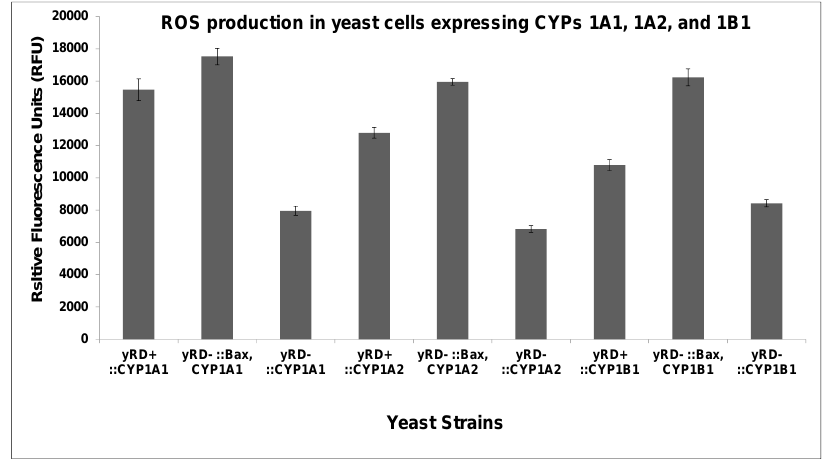
Figure 4. Measurement of ROS production in yeast strains, yRD + ( + CPR), yRD − :: Bax (–CPR), and yRD − (–CPR), expressing CYP proteins. CYP expression is driven by ethanol-inducible ADH2 promoter while Bax expression is driven by the GAL1 promoter, which is de-repressed in ethanol. ROS production in the three strains expressing CYP1A1, CYP1A2, and CYP1B1. The bar charts show that ROS production was higher in the strains containing Bax and no CPR than the strains that contained CPR, the strains that contained neither CPR nor Bax had the lowest ROS. The significance of ROS production in yeast cells was determined using between-groups ANOVA based on a p < 0.05. There was a